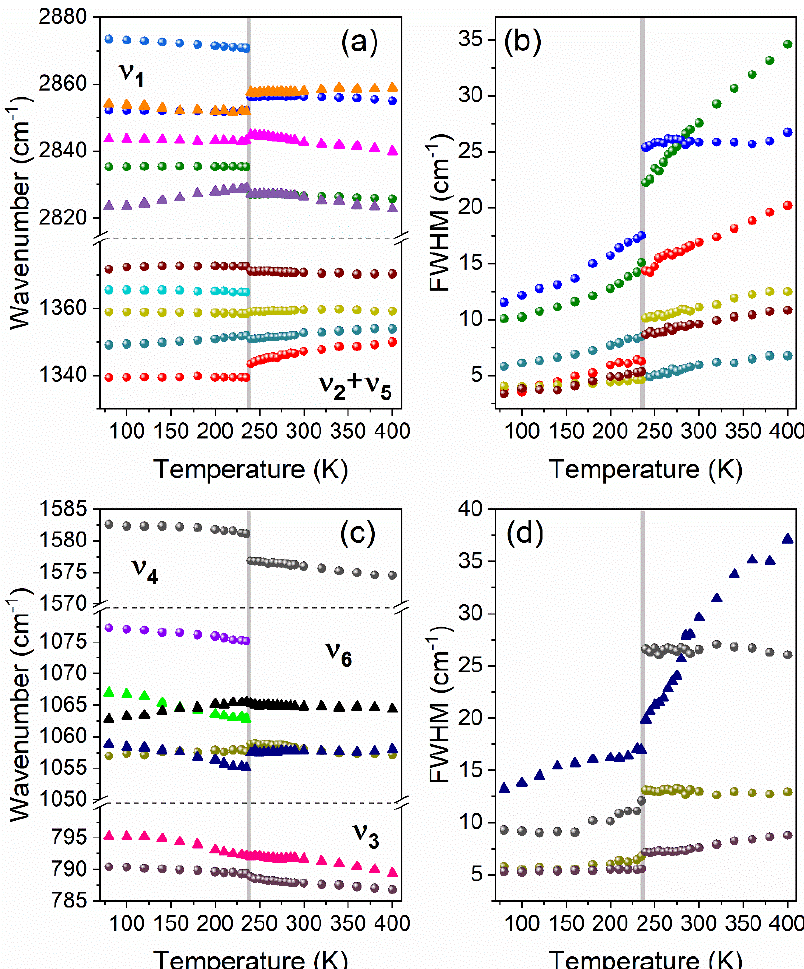
Figure 4. The temperature evolution of selected Raman (circles) and IR (triangles) wavenumbers ( a , c ) and bandwidths ( b , d ) of bands corresponding to the ν 1 , ν 2 + ν 5 ( a , b ) as well as to ν 3 , ν 4 and ν 6 ( b , d ) stretching vibrations of formate linkers. Horizontal dashed lines separate ranges of ν 1 – ν 6 modes, vertical grey lines correspond to the PT temperature. Two Raman bands observed above 3260 cm − 1 , corresponding to the ν as NH 2 modes, exhibit weak shifts (less than 2.5 cm − 1 ) at the PT temperature (Figure 5a). Almost no changes at the PT temperature are also observed for the IR counterparts. Raman bands corresponding to the ν s NH 2 and ω NH 2 modes are significantly more sensitive, i.e., they exhibit upshift by 10.8 cm − 1 and downshift by 8.7 cm − 1 , respectively. They also disclose significant broadening by ca 14.1 cm − 1 and 49.5 cm − 1 , respectively (Figure 5b). The shifts observed for the ν NH + modes are up to 8.0 cm − 1 . Shifts observed for the Raman-active ν as CH 3 and ν s CH 3 modes are also strong, up to 12 cm − 1 . The rocking vibrations exhibit weaker changes and seem to be less affected by the PT. The only exception is the 1202 cm − 1 mode (at 300 K), for which the upshift on heating is equal to 11.5 cm − 1 . The ν CNN skeleton vibrations are weakly affected by the